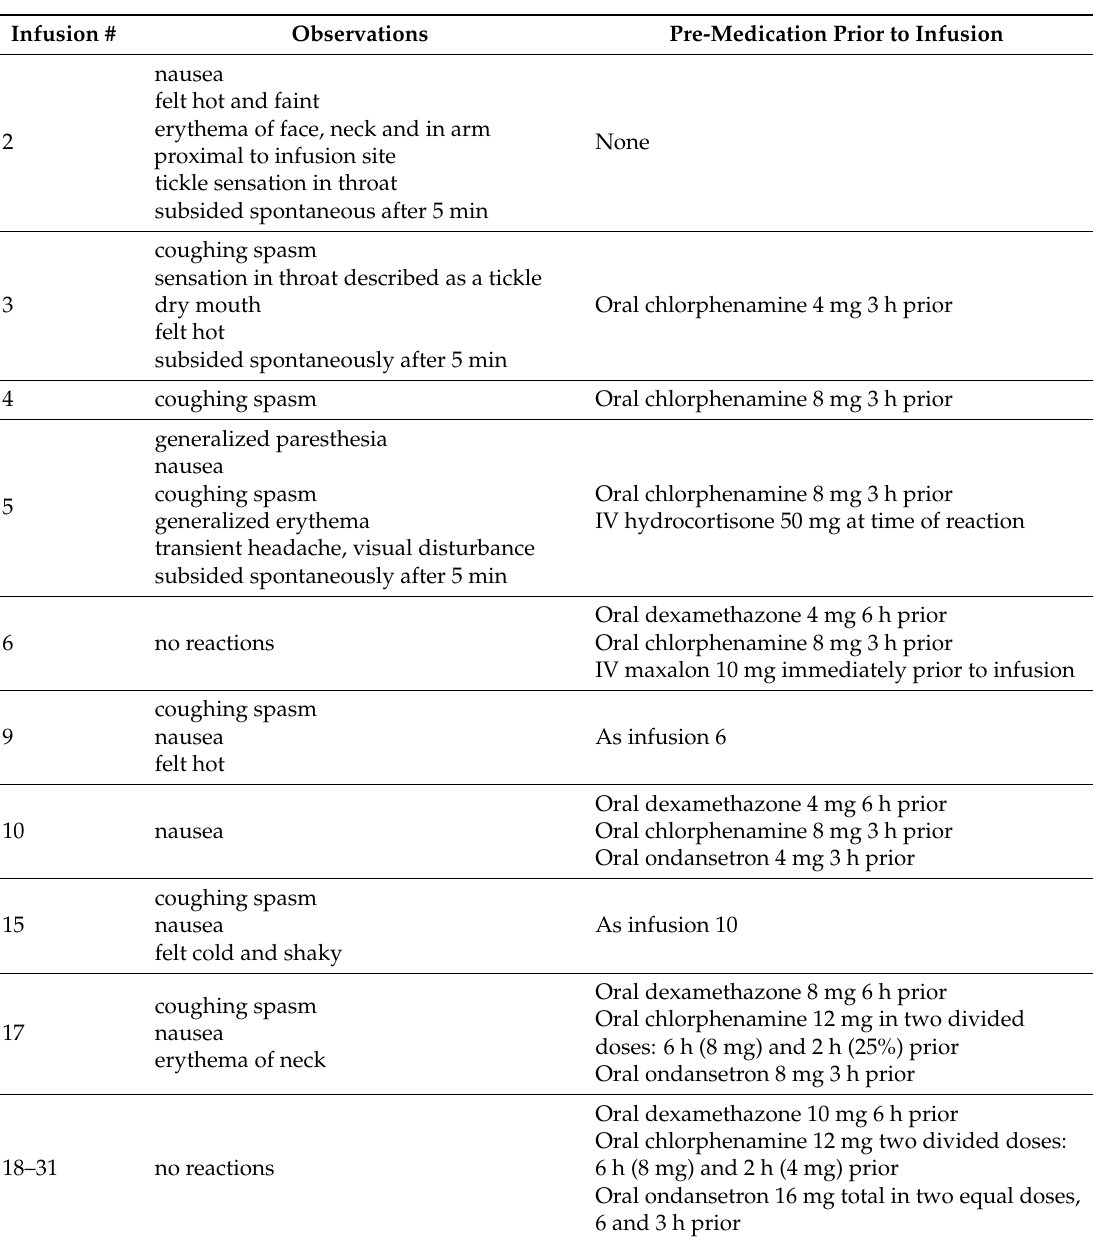
Table 5. Adverse reactions to EE-TP administration in Patient